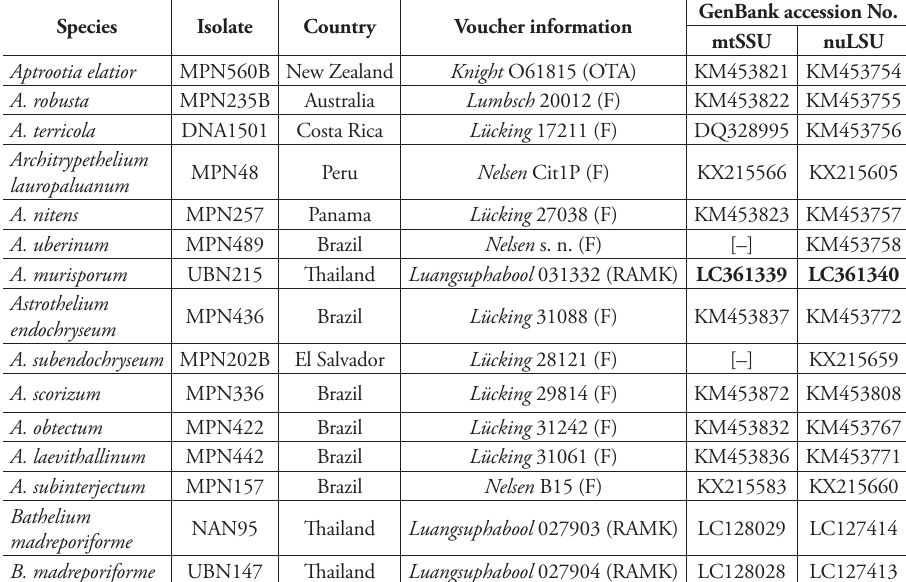
Table 1. Species, location, voucher information and GenBank accession numbers for samples used in this study. Newly obtained sequences in bold and missing data are indicated by